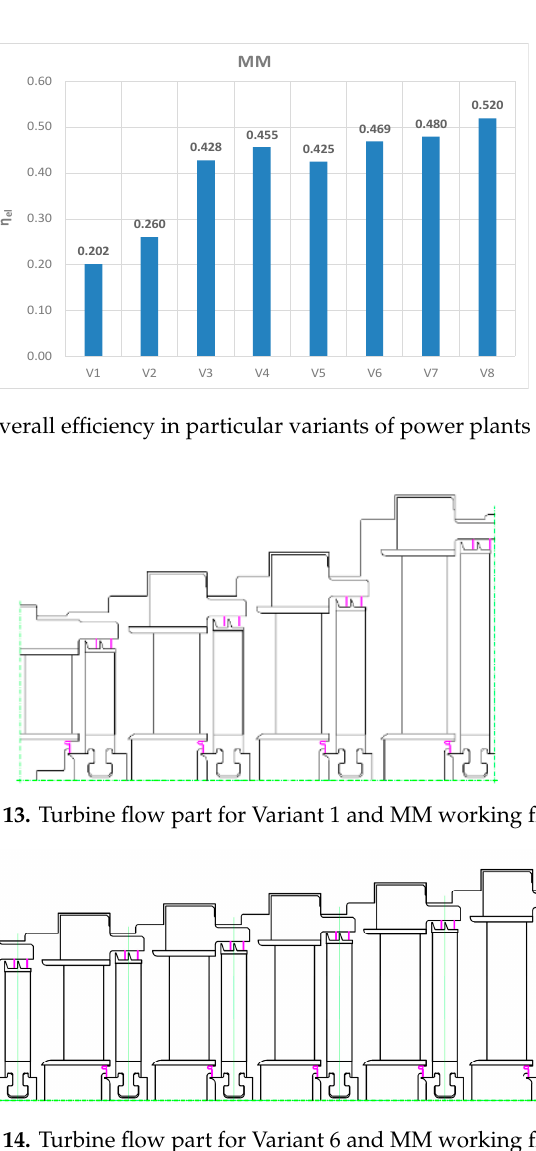
Figure 11. Variant 8—pressure of interstage superheater.